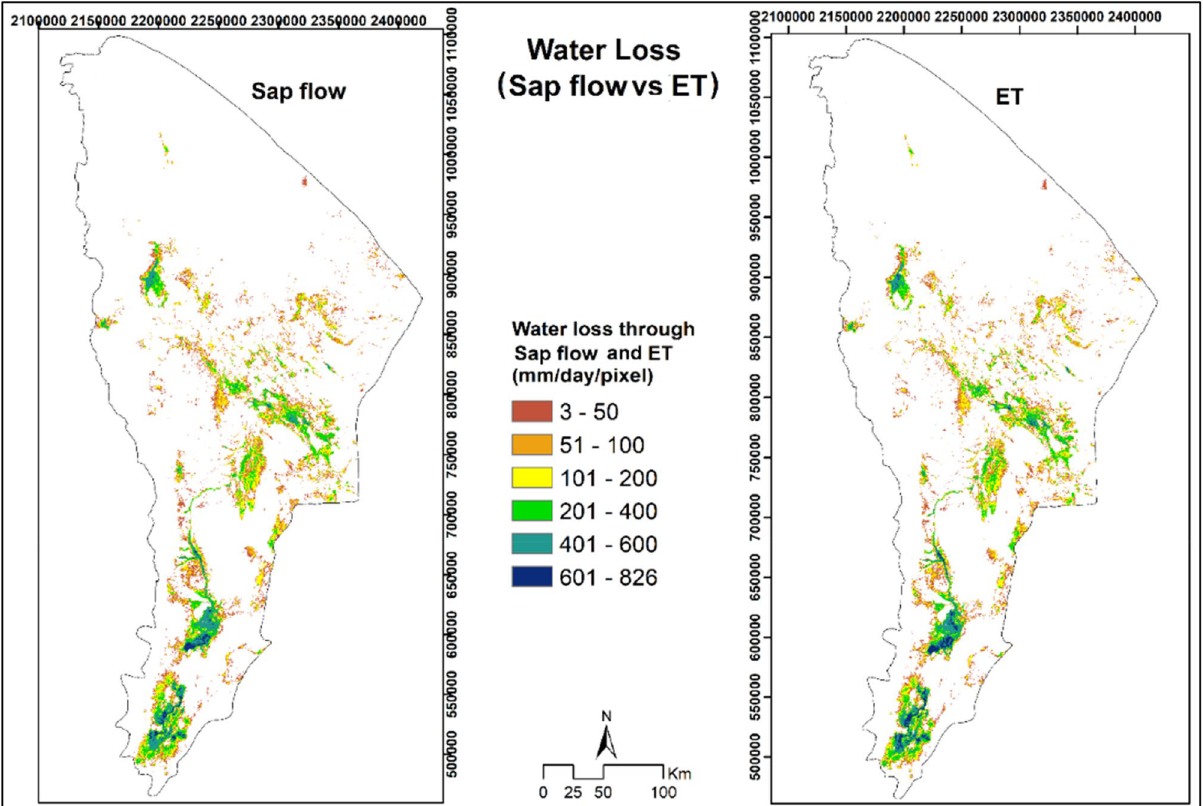
Figure 7. Water loss over areas invaded by Prosopis stands through sap flow of individual Prosopis trees (left side) and ETa (right